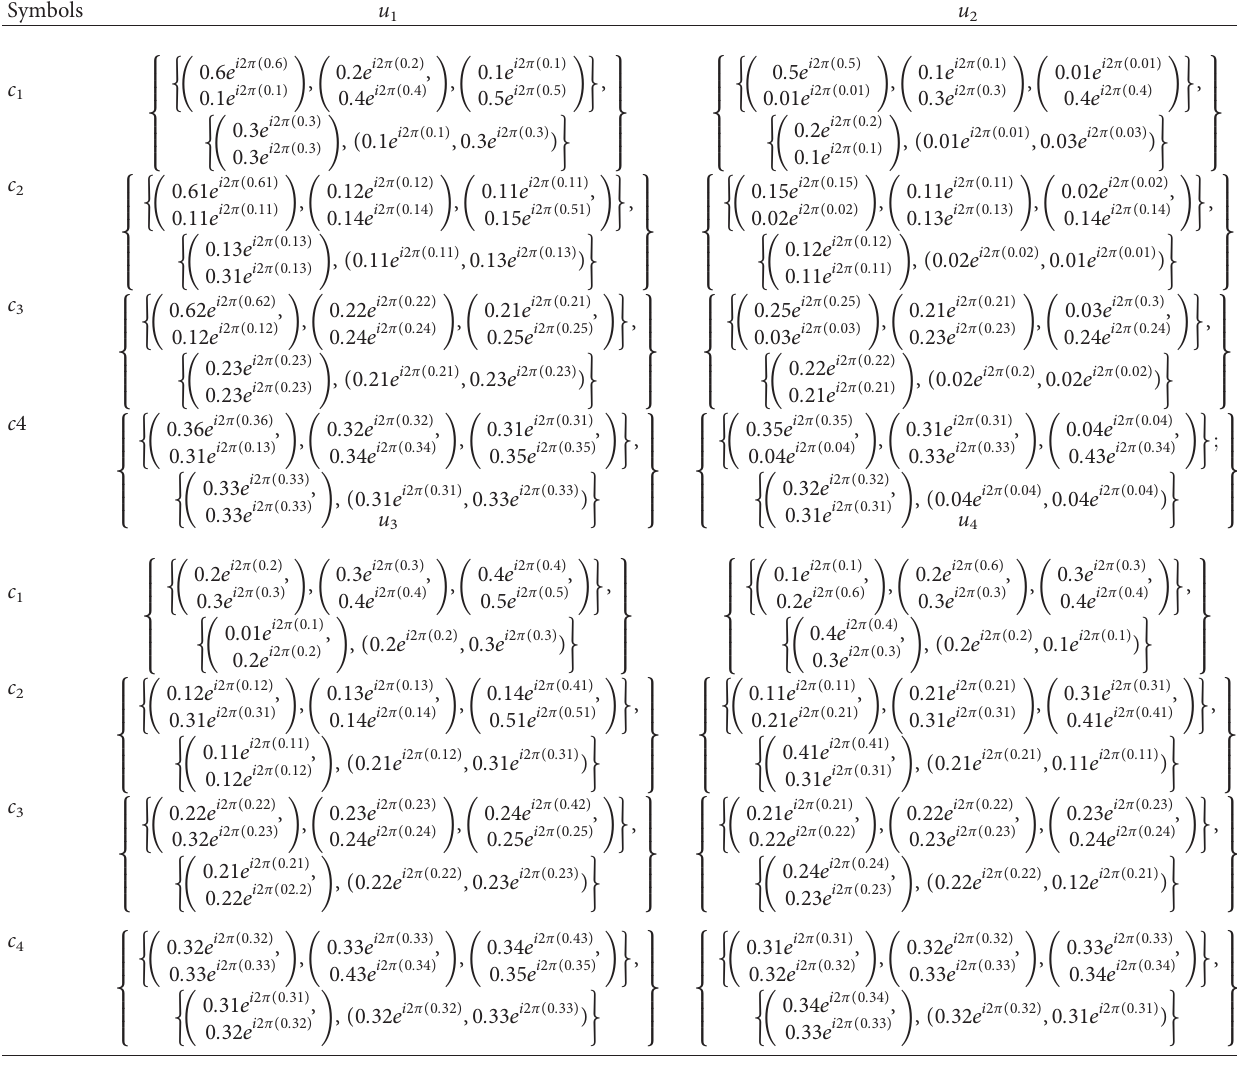
Table 1: Original decision matrix, all items of which are in the form of complex numbers. Symbols u